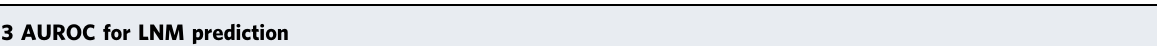
Table 3 AUROC for LNM prediction Model